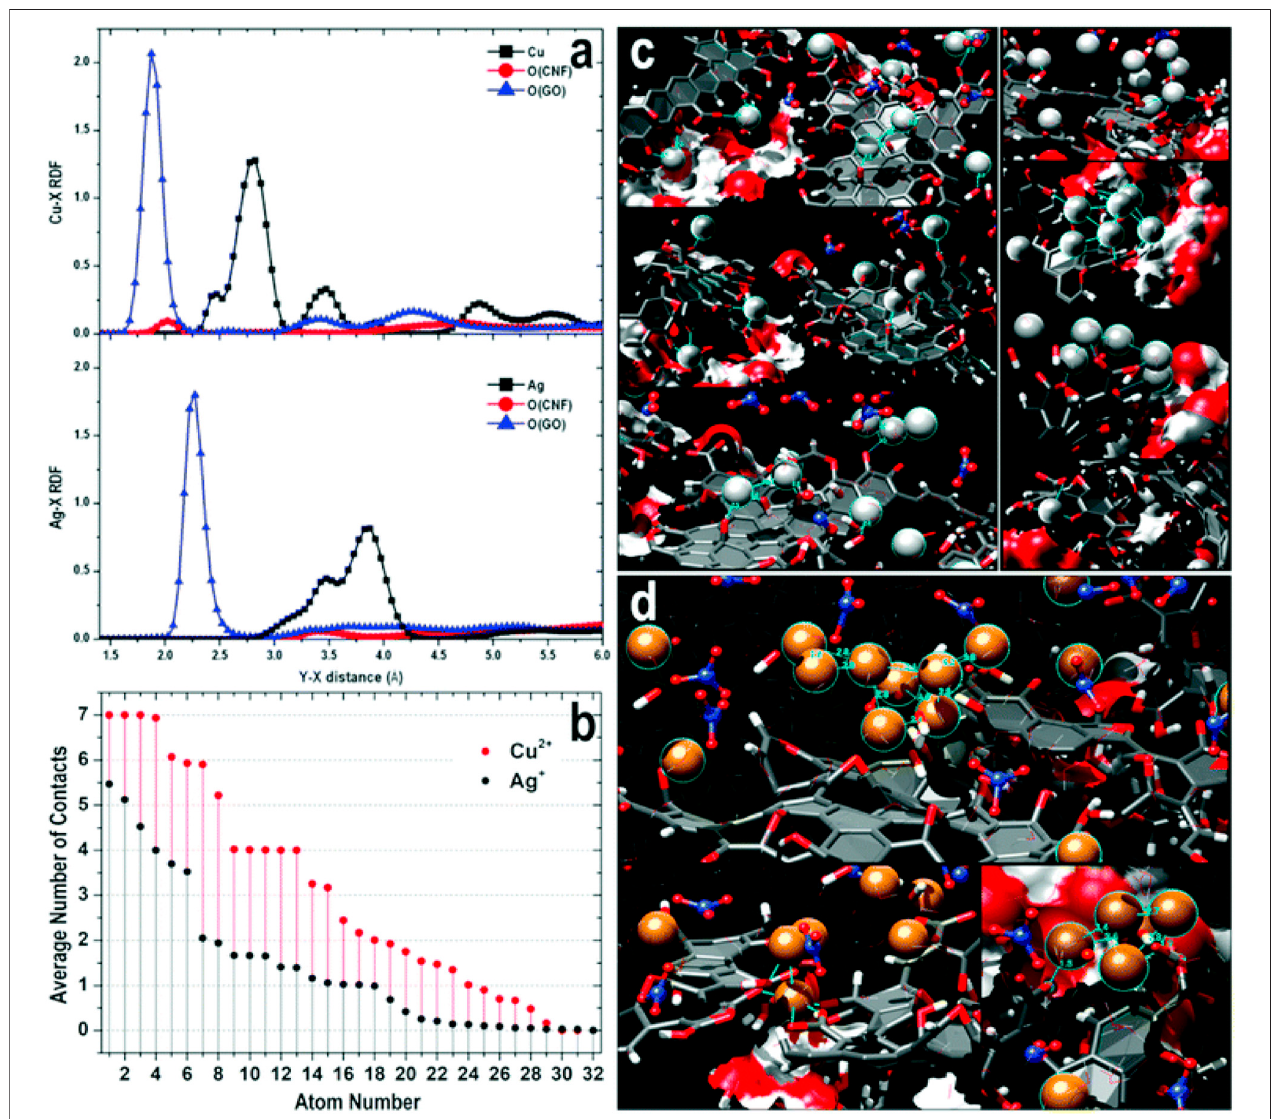
FIGURE5|(A) Normalizedradialdistributionfunctions(RDFs)oftheadsorptionofCu2+andAg+onCNF – GO, (B) theAveragenumberofmetalionsfoundaround each metal ion (within 7 Å) during the simulation; The total number of metal ions is 32 in each case, (C) Ag + ions are represented with light grey spheres and NO3 − ions are rendered with ball and stick models (blue nitrogen atoms), (D) Adsorption of Cu2+ ions on CNF – GO (layer model). Cu2+ ions are represented with orange spheres and NO3 − ions are rendered with ball and stick models (blue nitrogen atoms). CNFs are rendered through red (oxygen) and white (hydrogen) surface patches (carbon — light grey), and GO is displayed through dark grey stick models with fi lled aromatic rings. Figure reprinted from Ref. (Valencia et al., 2019). This Open Access Article is licensed under a Creative Commons Attribution-NonCommercial 3.0 Unported Licence.